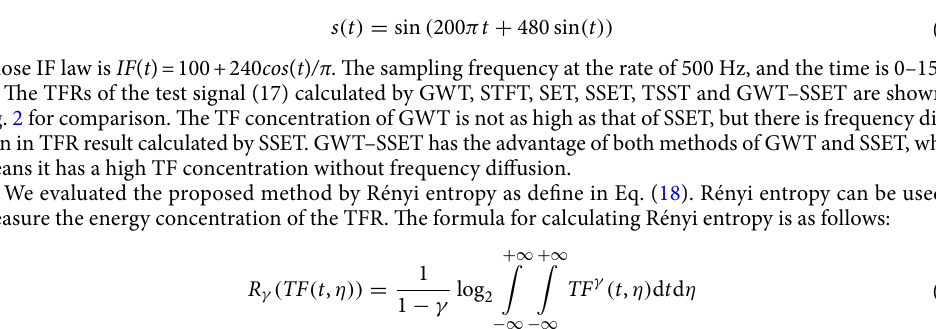
Monocomponent signal. The expression of the simulated monocomponent signal is: